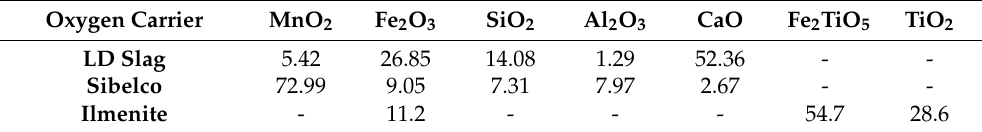
Table 3. Chemical composition of selected oxygen carriers (in wt%). Ilmenite contains additionally 5.5 wt% of inert materials, which have not been taken into account for thermodynamic calculations. Both Sibelco and Ilmenite were